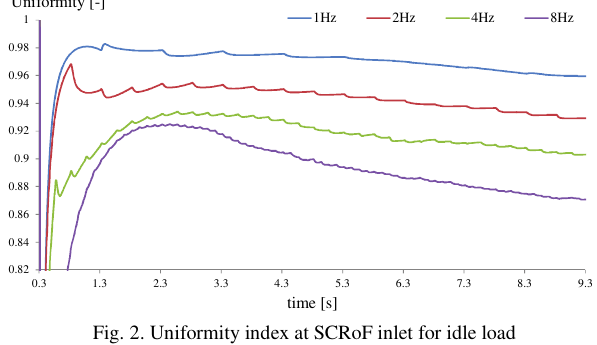
Fig. 2. Uniformity index at SCRoF inlet for idle load